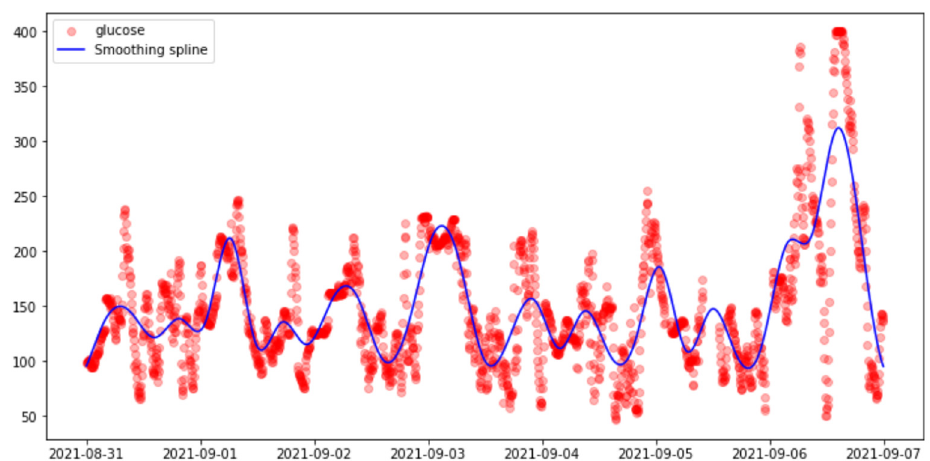
Figure 9. Comparing the true CGM time series with the smoothed CGM time series using smoothing spline, in one week period for patient 588.